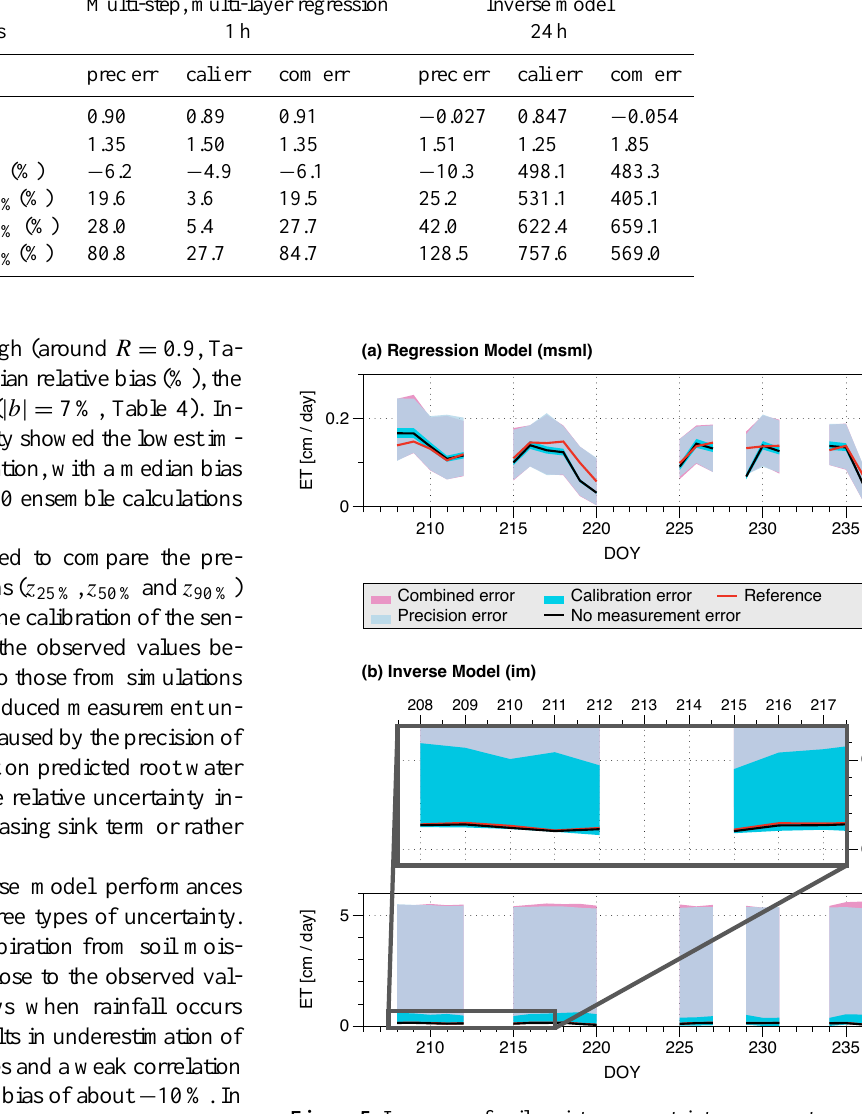
Figure 5. Influence of soil moisture uncertainty on evapotranspira- tion estimated with the msml regression model (a) and the im (b) . The red line is the evapotranspiration from the synthetic data (Ref- erence). The colored bands indicate the 95% confidence intervals.